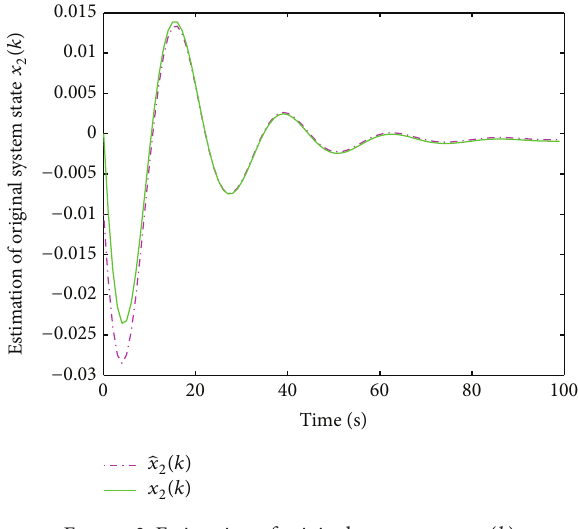
Figure 3: Estimation of original system state 𝑥 2 (𝑘) .